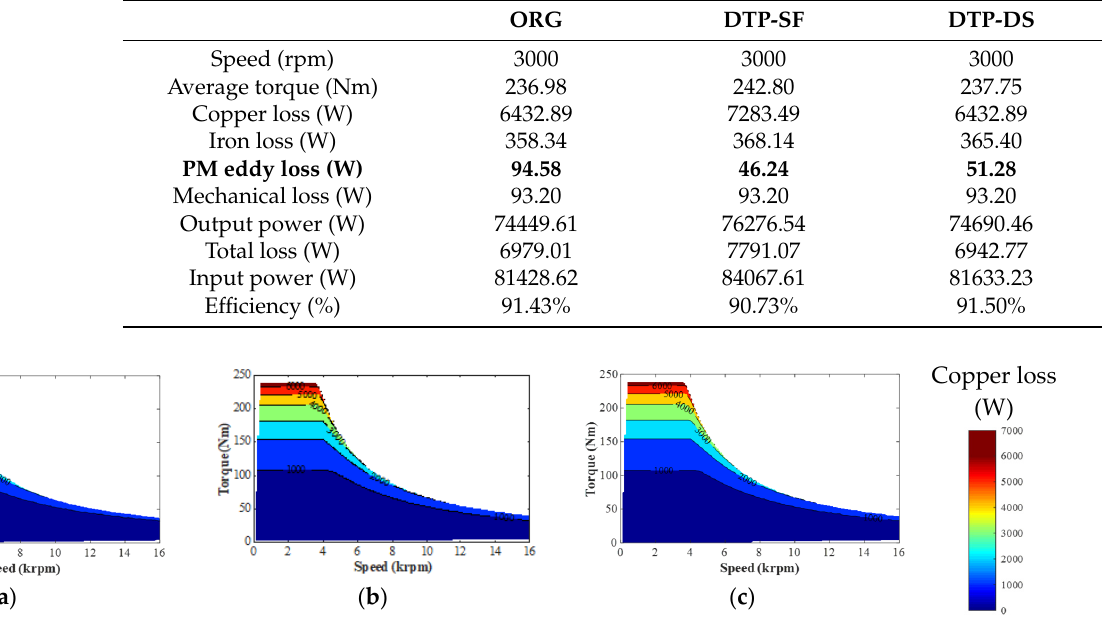
Figure 32. Copper loss maps of different winding configurations. ( a ) ORG; ( b ) DTP-SF; ( c ) DTP-DS.